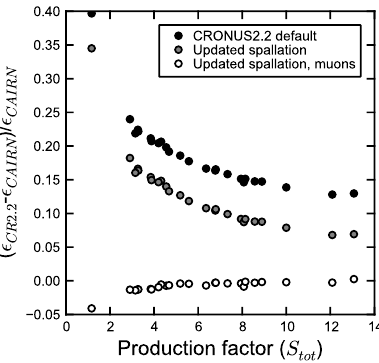
Figure 7. Difference between denudation rate calculated by CAIRN ( (cid:15) CAIRN ) and the denudation rates calculated by CRONUS- 2.2 ( (cid:15) CR2.2 ), but with CRONUS-2.2. parameters updated to have spallation and muon production reflecting production in CAIRN, which is based on (Braucher et al., 2011). Data are from the Scher- ler et al. (2014)